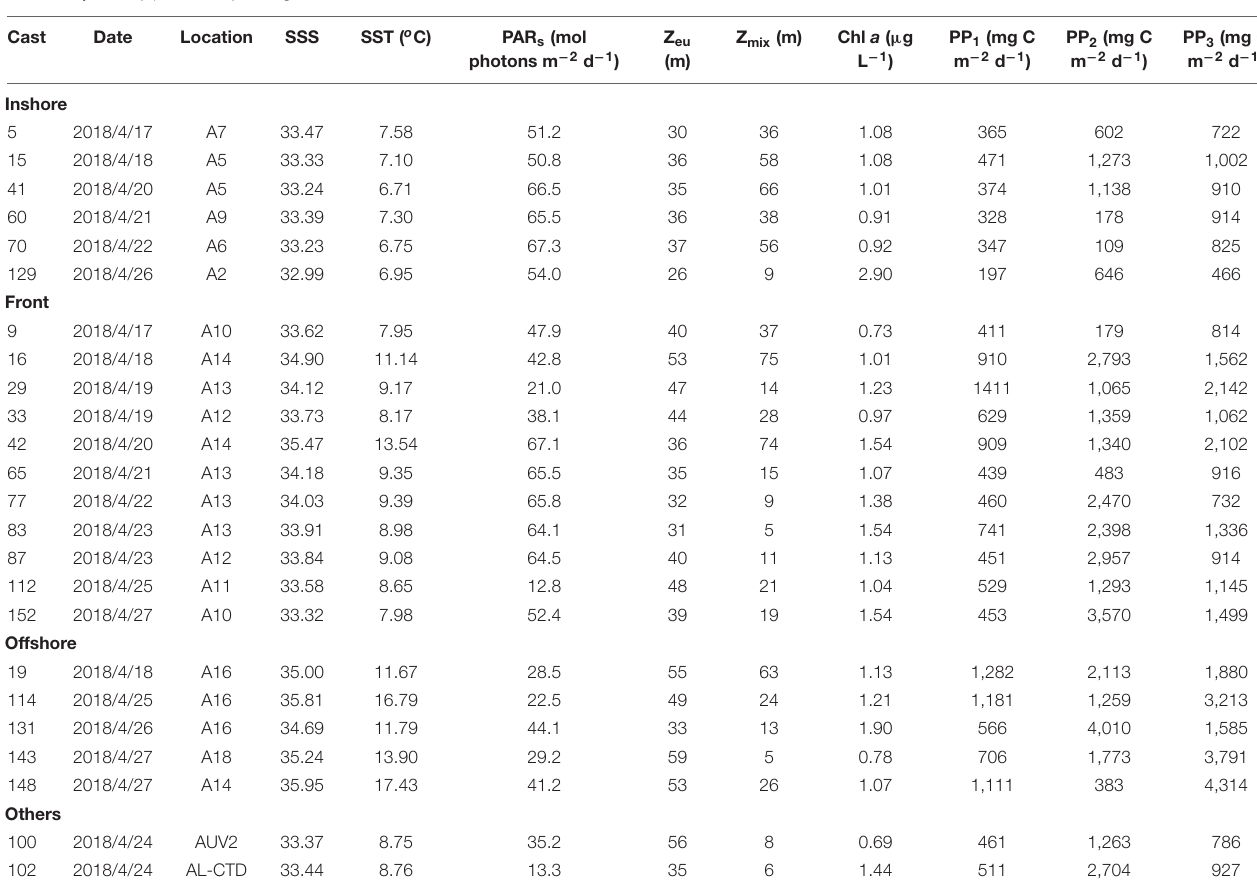
TABLE 2 | Primary productivity during